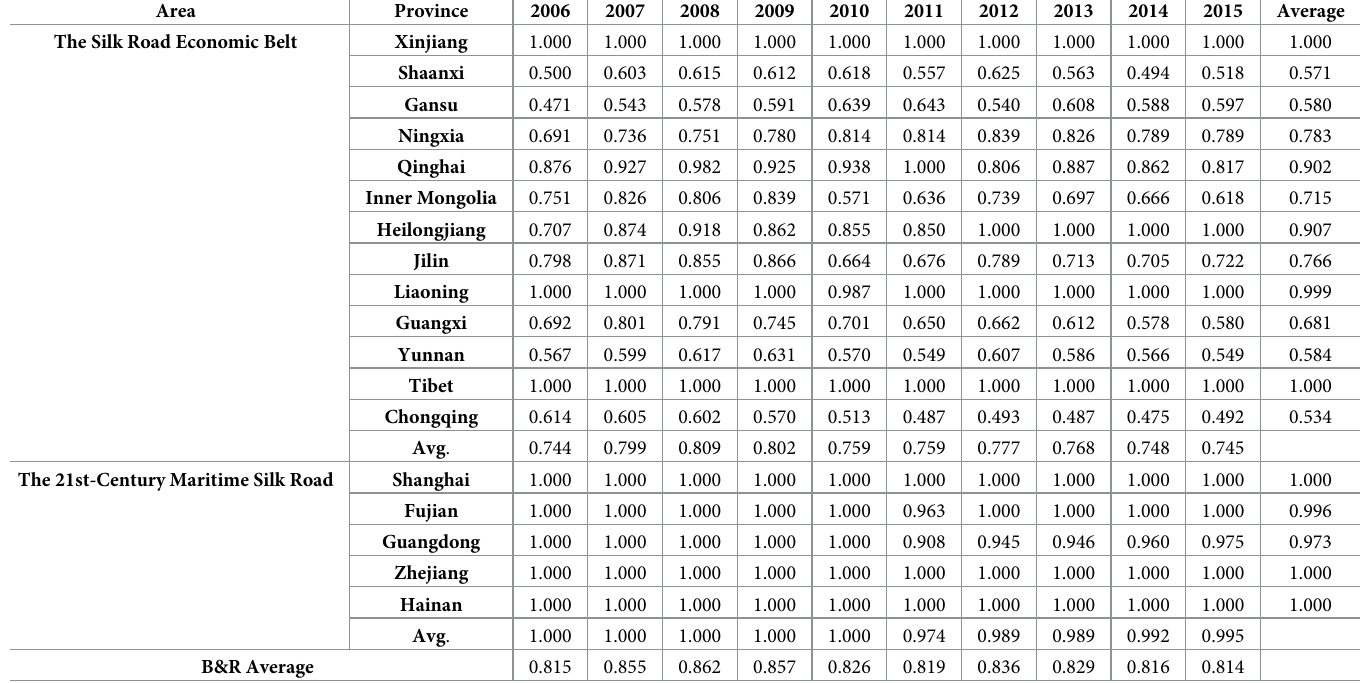
Table 4. Comprehensive technical efficiency of agricultural carbon emissions of the key provinces along the Belt and Road (B&R) within 2006–2015.